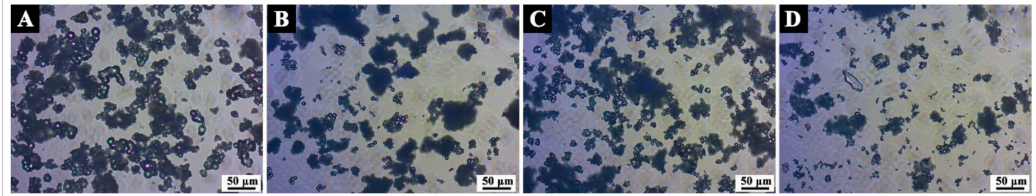
Figure 1. The OM morphology of microcapsules prepared at different stirring rates: ( A ) 400 rpm, ( B ) 600 rpm, ( C ) 800 rpm, ( D ) 1000 rpm.